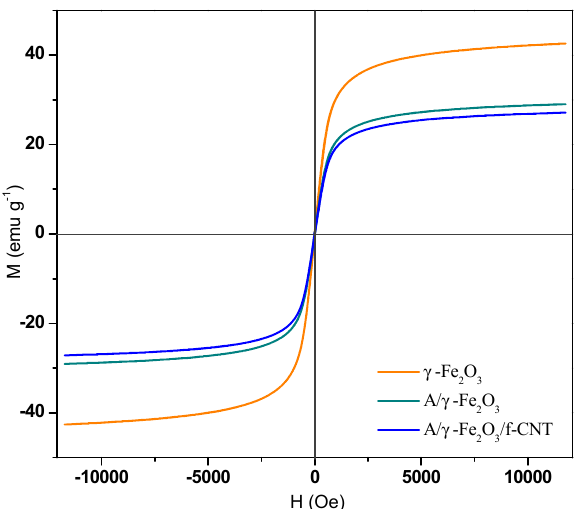
/ γ -Fe / γ -Fe / f-CNT 2 O 3 and A 2 O 3